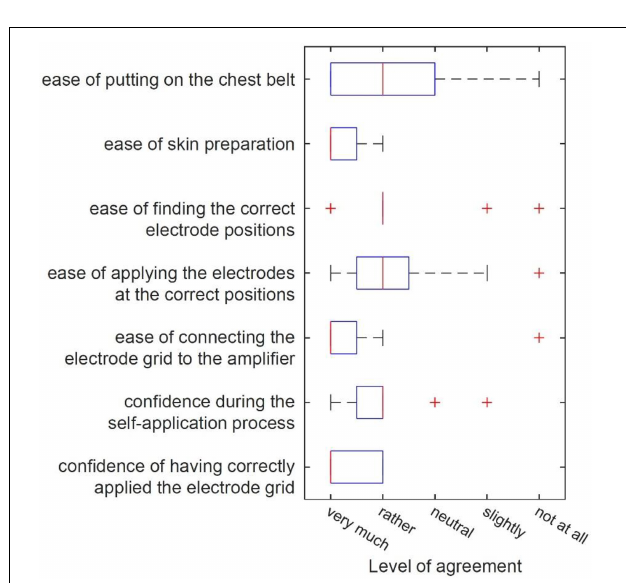
FIGURE 7 | Box plots of answers given by the 12 participants of the self-application study concerning different aspects of self-applicability.